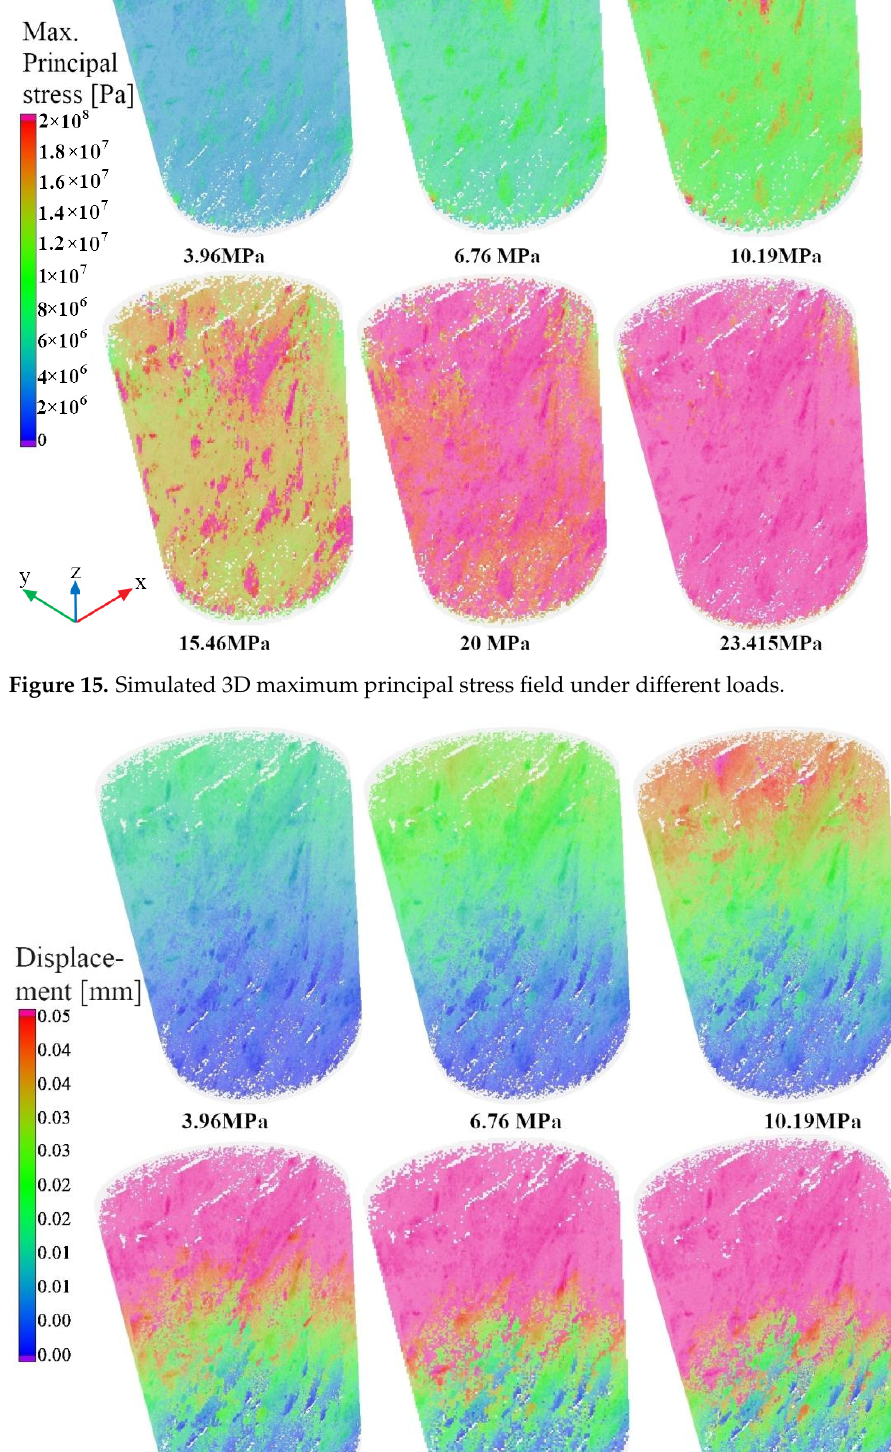
Figure 16. Simulated 3D displacement field under different loads.